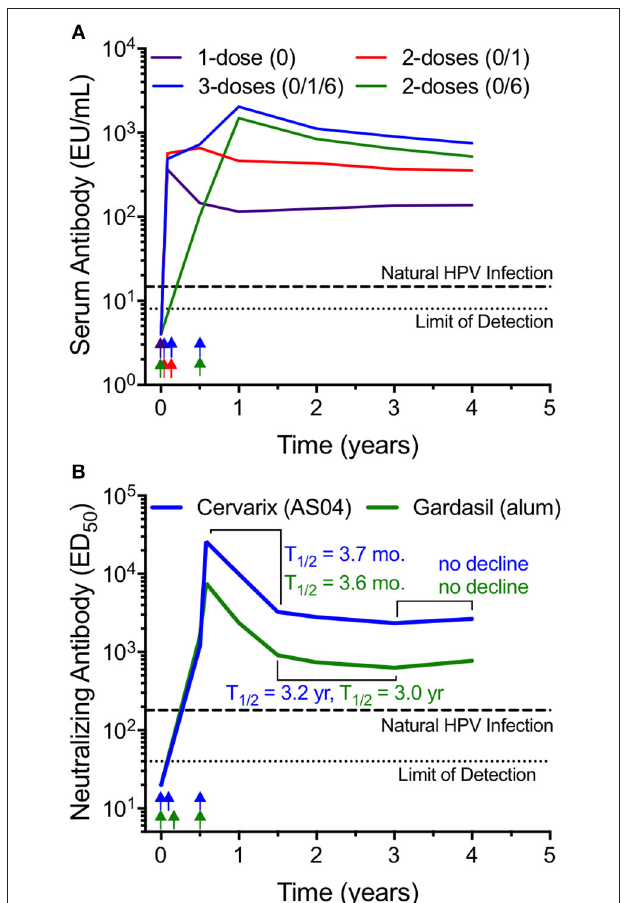
FIGURE 1 | Long-term antibody maintenance after vaccination with HPV VLP vaccines with or without Toll-like receptor 4 (TLR4) agonists. (A) Serum antibody responses to HPV16 were monitored by ELISA for up to 4 years following various vaccination schedules (1 dose; 2 doses at 0 and 1 month; 2 doses at 0 and 6 months; 3 doses at 0, 1, and 6 months) with AS04-adjuvanted, VLP-based Cervarix ® HPV vaccine. The graph was prepared using data provided in Table 1 from Safaeian et al. (42). Longitudinal analysis was limited to subjects with sera available at each time point, with group sizes ranging from 52 to 140. (B) Neutralizing antibody responses against HPV16 were assessed longitudinally following a three-dose vaccination schedule with either Cervarix (AS04 adjuvant), or Gardasil ® (alum-only adjuvant). The graph was prepared by combining the